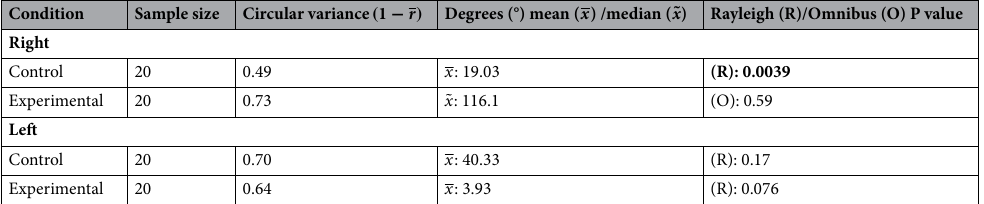
Table 1. Movement patterns of free-roaming crabs exposed to control vs experimental stimuli. Results include: Circular variance, a measure of circular spread of the data points; mean/median bearing direction reported in degrees (°) across all individuals; Rayleigh test for significance of mean direction (R), or omnibus test for significance of median direction (O); Data separated by stimulus direction (Right = 116.1°, Left = 296.1°). Significant values are in